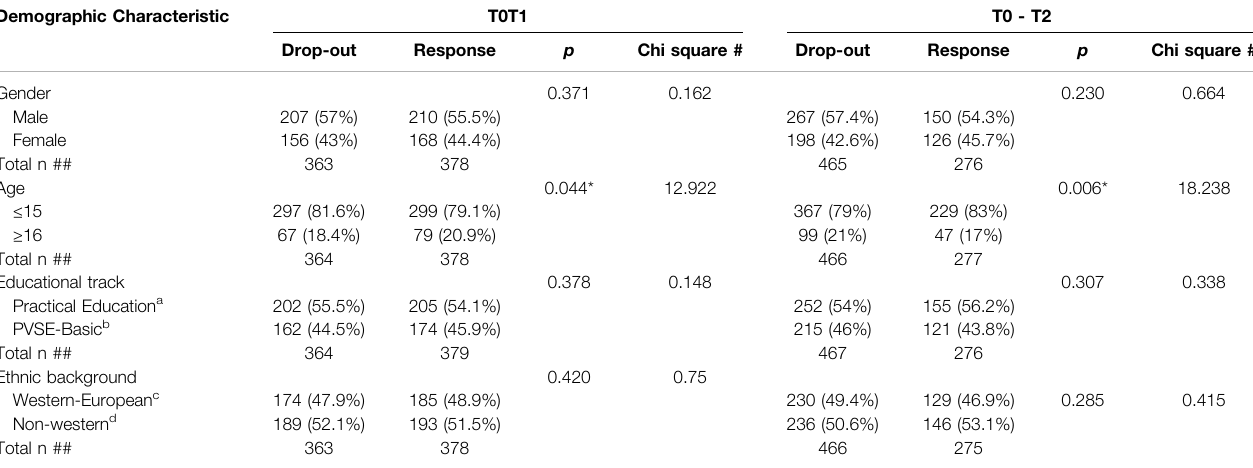
TABLE 2 | Background characteristics intervention and control groupand Dropout T0 — T1 and T0 — T2 Demographic Characteristic T0T1 T0 -